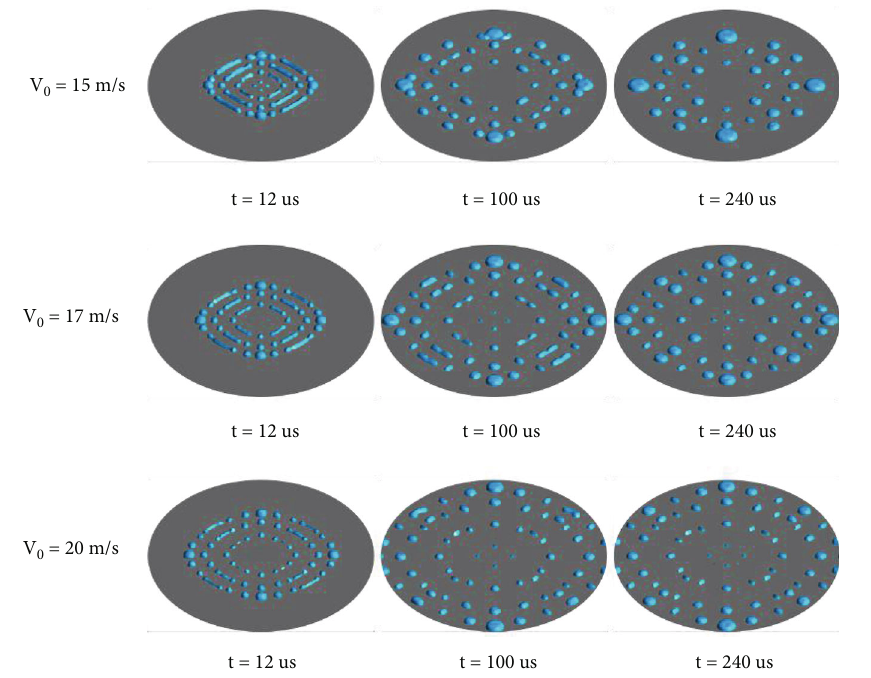
Figure 6: Spreading process of droplets with diameter of 30 μ m.